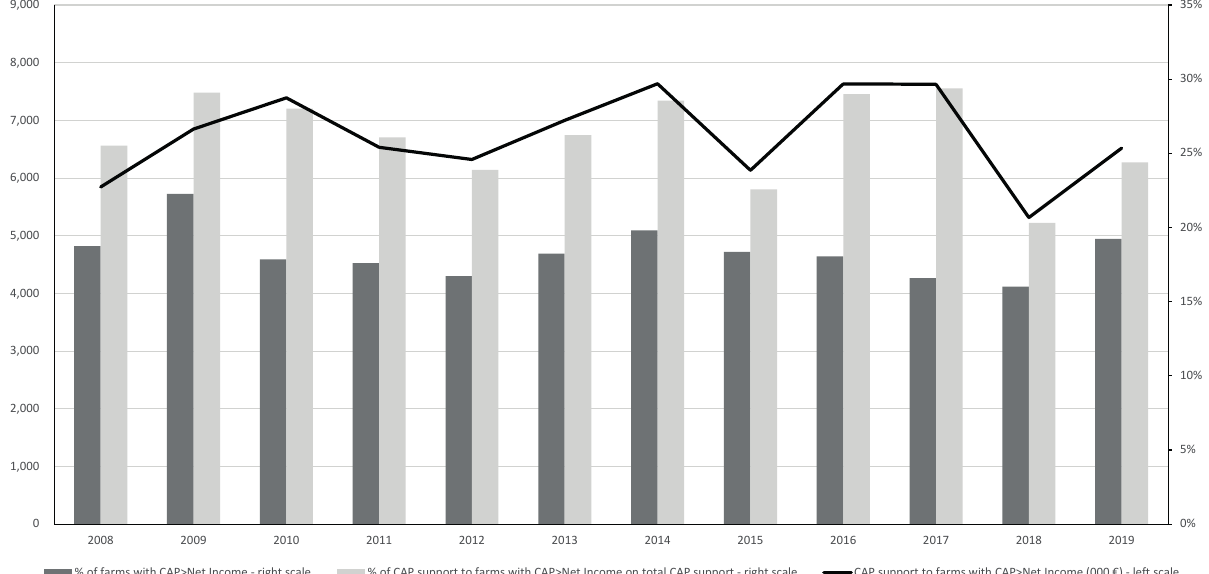
Figure 11. CAP support and number of farms with CAP support > net income (included net income < 0) within the 2008-2019 Italian FADN balanced sample.